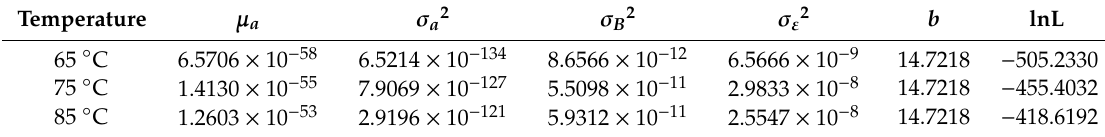
Table 2. Parameters of the degradation model under each stress levels with equal time index.